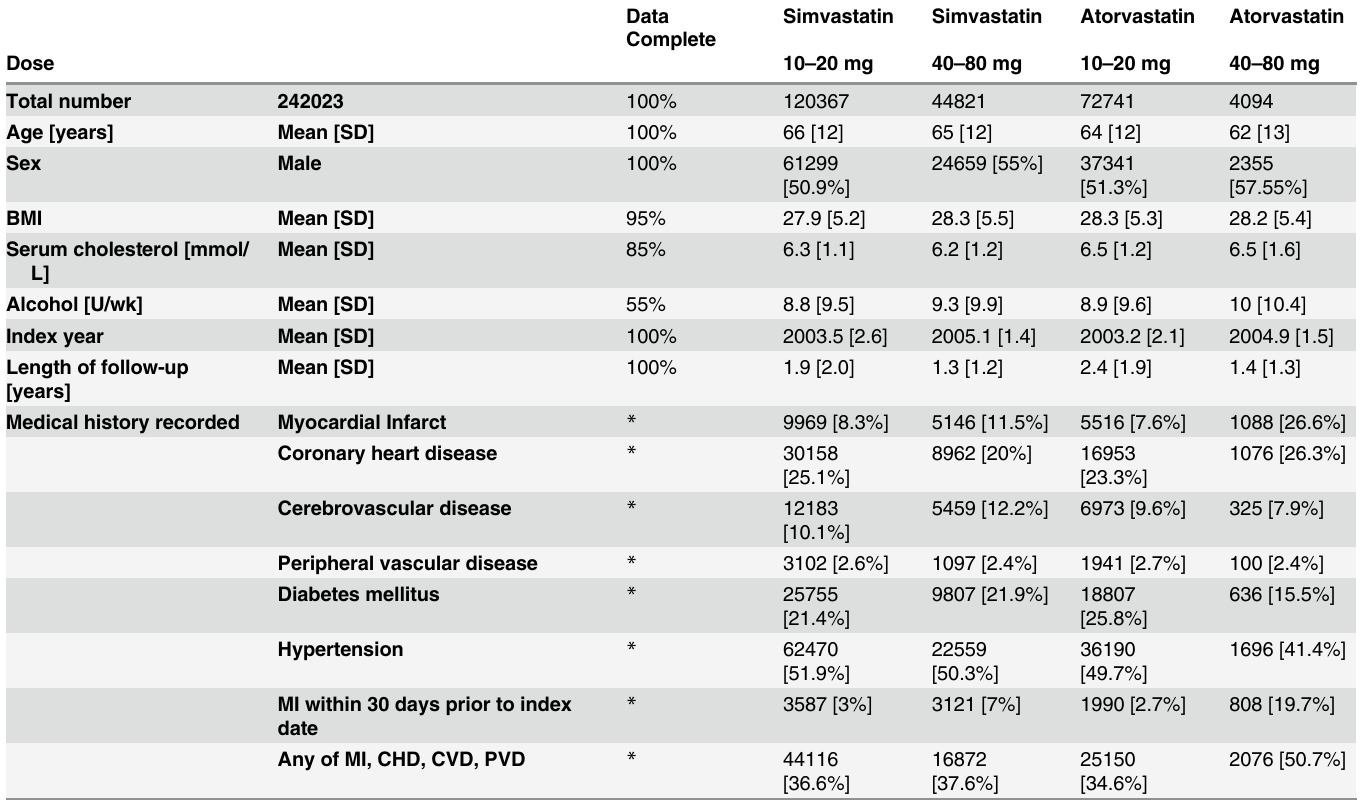
Table 2. Baseline characteristics of patients on simvastatin and atorvastatin grouped by statin